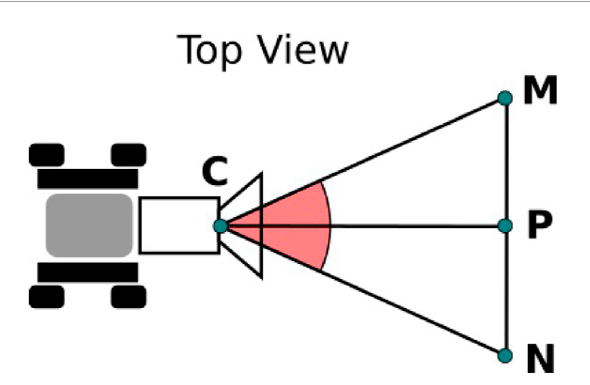
FIGURE 8 Top view schematic of the camera field of view. NM is the width of the field of